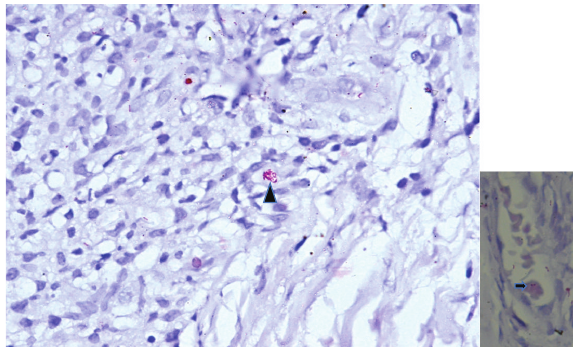
Figure 5: Magnified view of dermis showing foam cells with collectionofleprabacilli(globi)(blackarrowhead)(Wade-Fitestain, 100X magnification); inset shows infiltration of capillary wall with lepra bacilli (black arrow) suggestive of Lucio